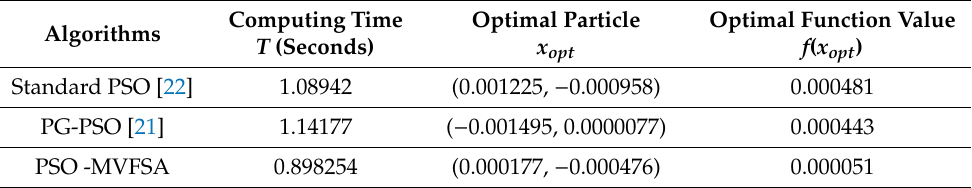
Table 2. Results of three algorithms based on